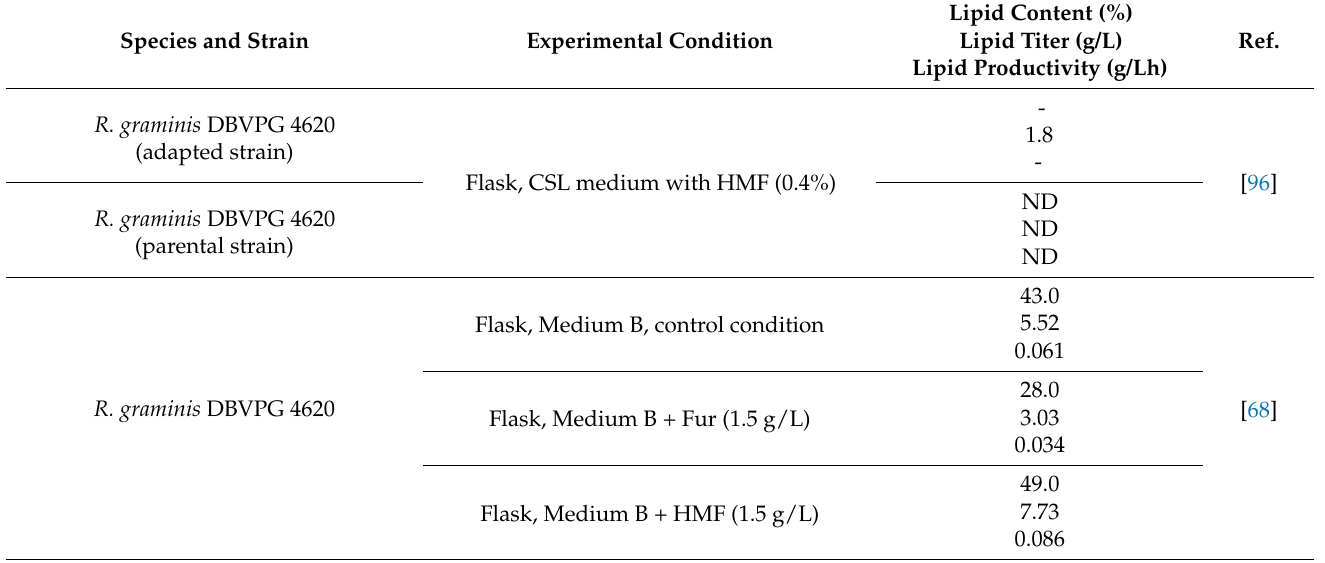
Table 2. Effect of the supplementation of cultivation media with different concentrations of fur- fural/HMF in lipid production by Rhodotorula graminis , Lipomyces starkeyi , Rhodotorula glutinis , Rhodotorula toruloides and Trichosporon cutaneum